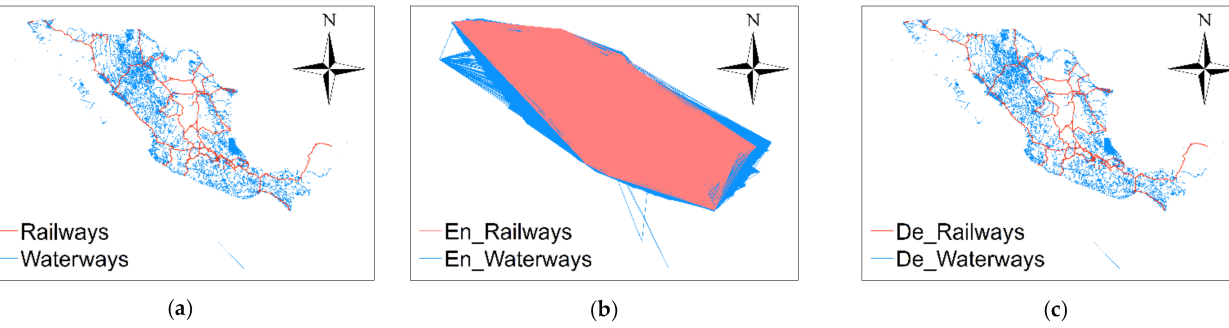
Figure 8. The map with two layers (railways and waterways). ( a ) The original map; ( b ) tThe cipher map; ( c ) the decrypted map.